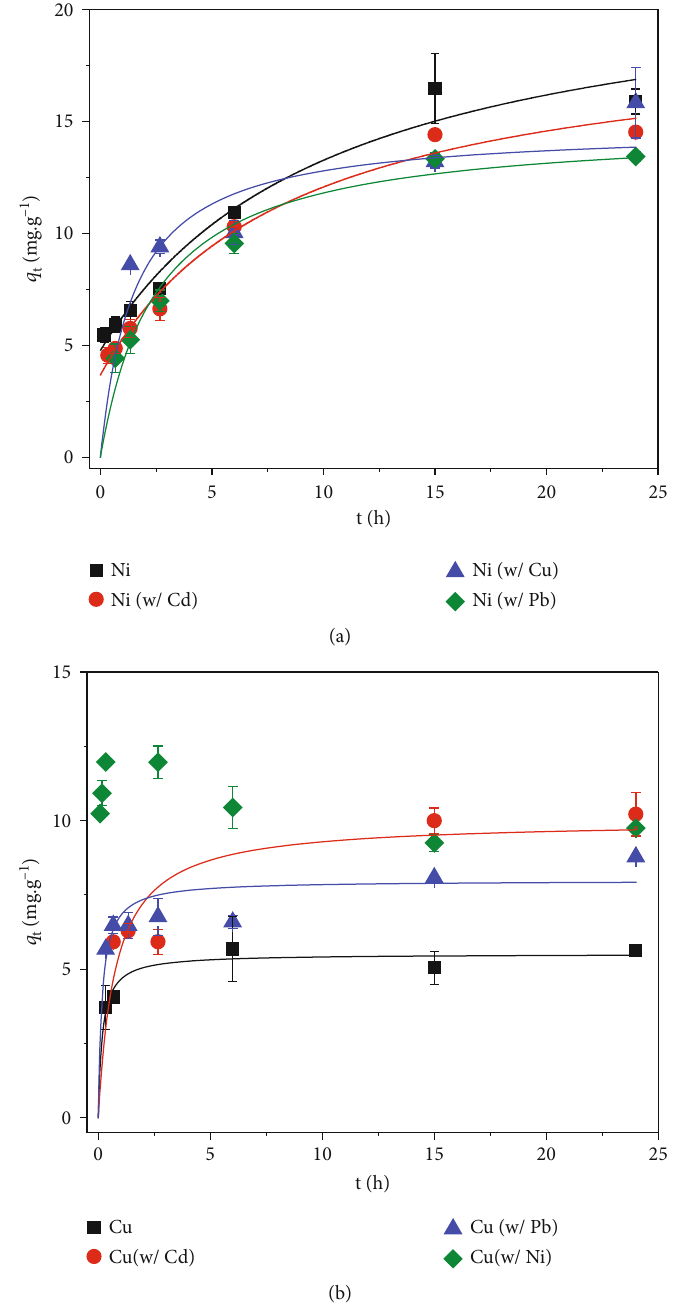
Figure 9: Adsorption kinetics for (a) nickel and (b) copper, isolated and in binary